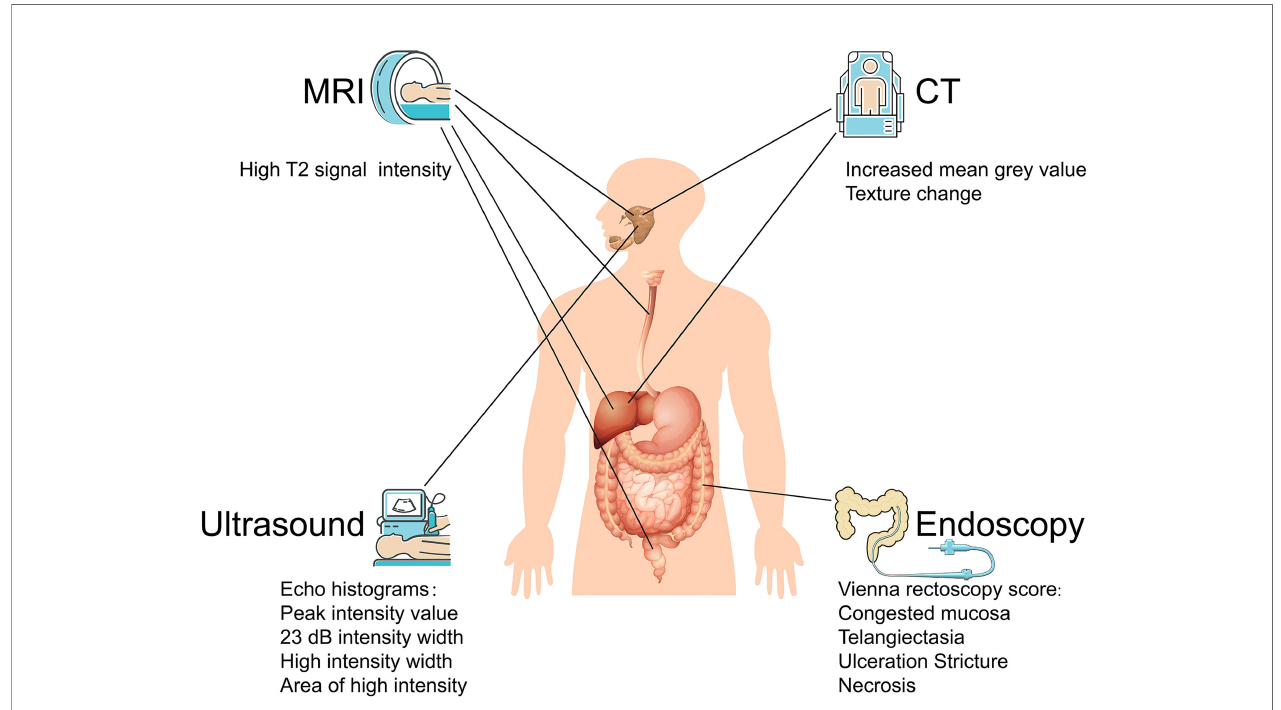
FIGURE 3 | Imaging based diagnosis of radiation-induced digestive injury. For radiation-induced digestive injury, MRI images manifest as high T2 signal intensity; CT images present increased mean grey value and texture change; ultrasound histogram images exhibit shift in peak intensity value, 23 dB intensity width and high intensity width/area; endoscopy discovers congested mucosa, telangiectasia, ulceration, stricture, and